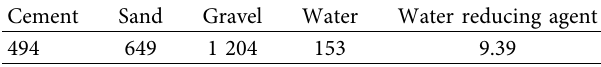
Table 3: Mix design of concrete (kg · m − 3